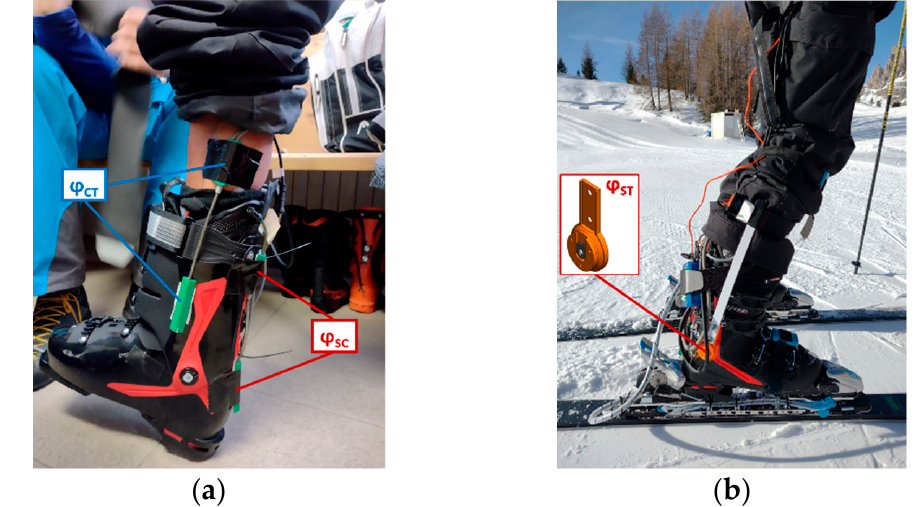
Figure 3. Alpine ski boot kinematic sensors: ( a ) medial view of the alpine ski boot with the electrogoniometric sensors; ( b ) lateral view of the alpine ski boot with the force sensors under the binding and the potentiometric sensor φ ST in the lateral side.